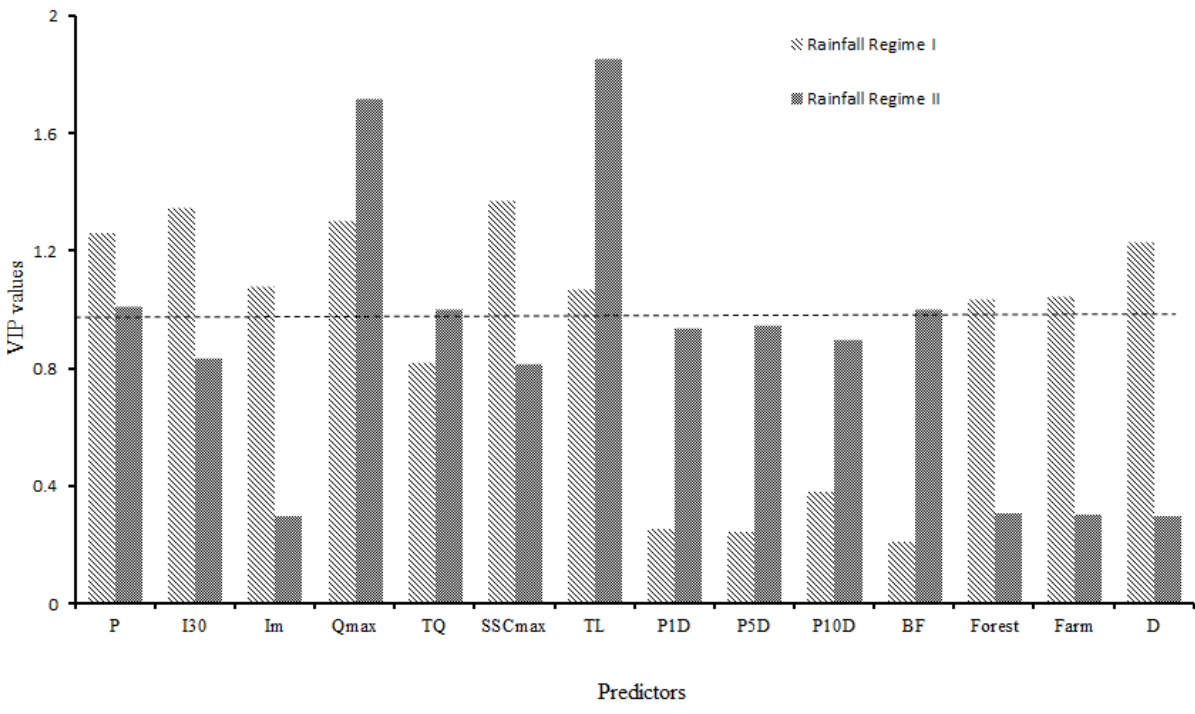
Figure 4. VIP values of each predictor for PLSR of runoff.